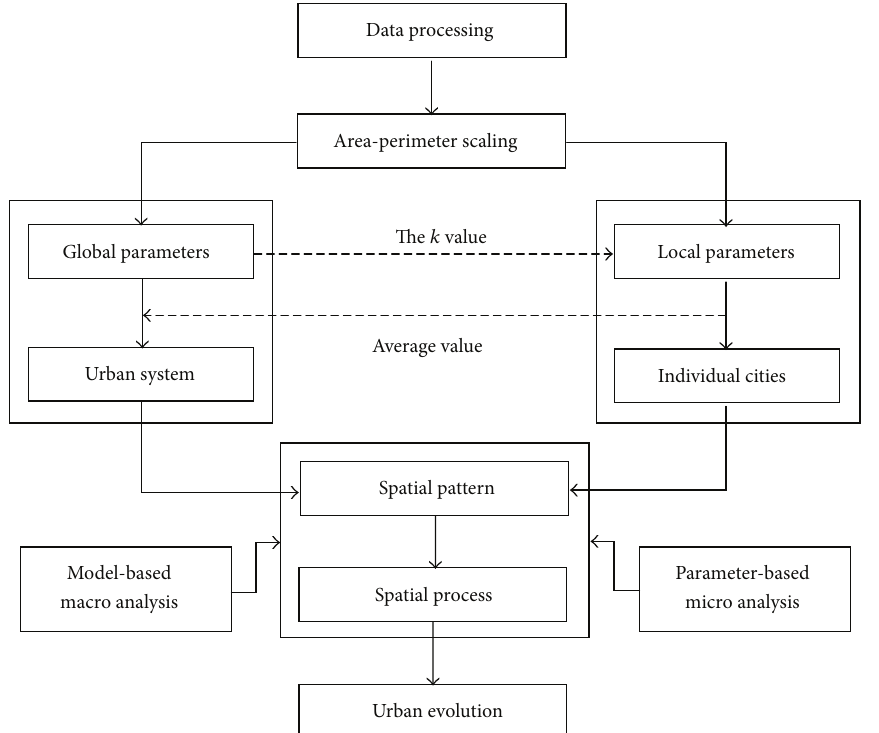
Figure 4: A schematic diagram of the urban analytical process based on the area-perimeter scaling.